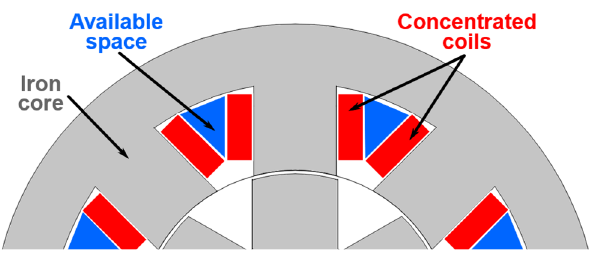
Figure 7. Free space available for placing coolers in the slots with concentrated windings.